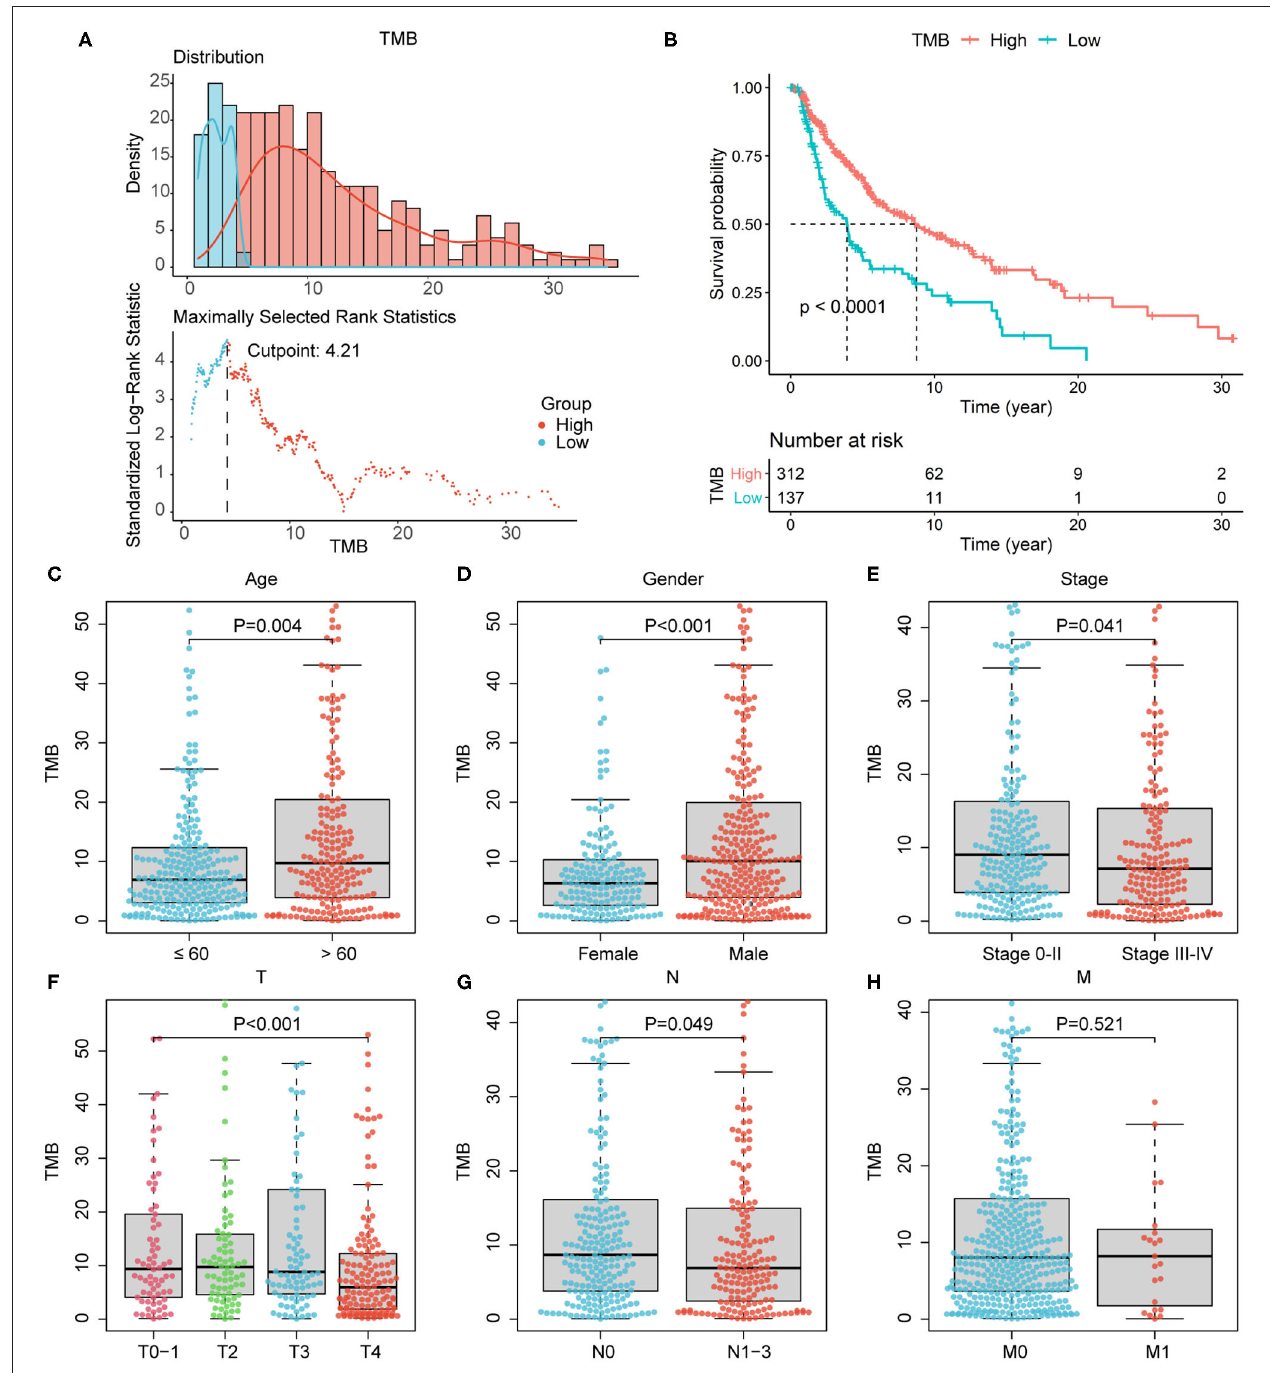
FIGURE 2 | Association of TMB with prognosis and clinical features. (A) The optimal cutoff of 4.22 according to maximally selected rank statistics. (B) According to survival analysis, high-TMB group correlated with better survival outcomes, with P < 0.0001. (C–G) Age over 60 years old, male, lower pathological stage, lower AJCC-T, and N stage correlated with higher TMB level. (H) The association of TMB with AJCC-M stage was not significant. AJCC, American Joint Committee on Cancer.